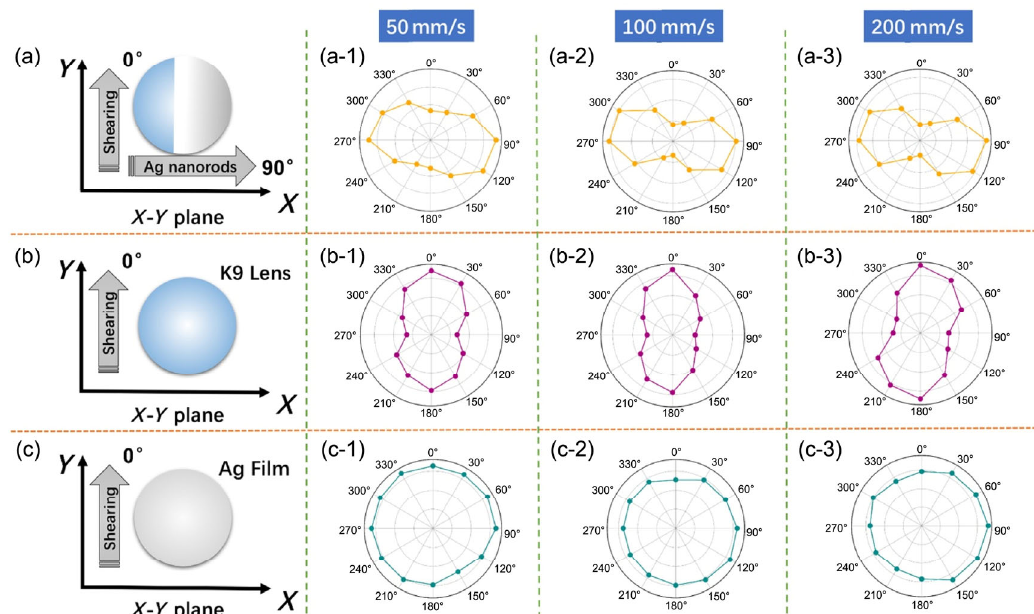
Fig. 4 (a–c) Illustration of the lower substrate. Relative Raman intensity graphs of 6CB on different substrates under shearing. The shear-flow speed is marked at the top of each pair. ((a-1)–(a-3)): performed on Ag nanorod film bases; ((b-1)–(b-3)): performed on K9 plano-convex lens; ((c-1)–(c-3)): performed on flat Ag film bases.